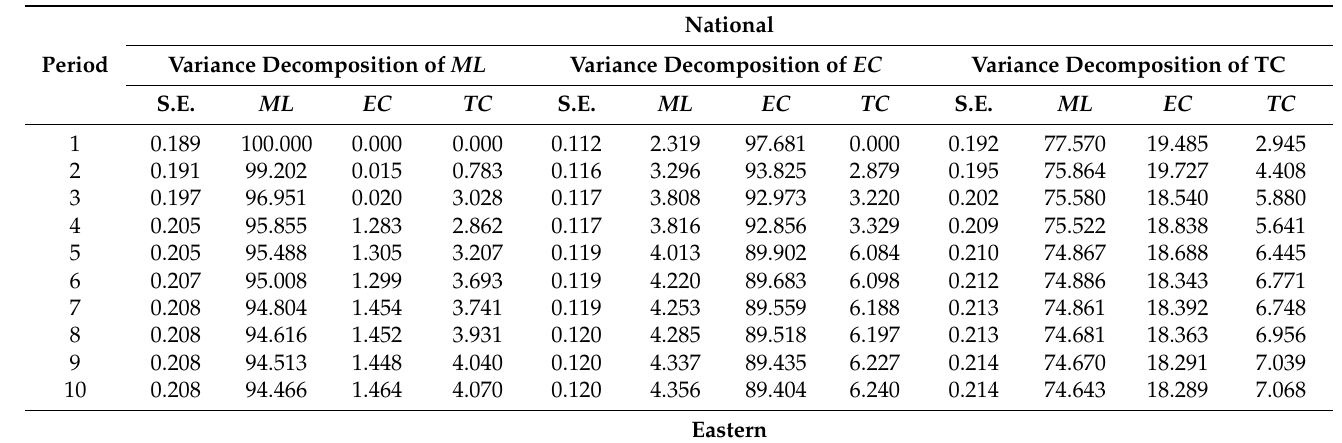
Table 10. Results of Variance